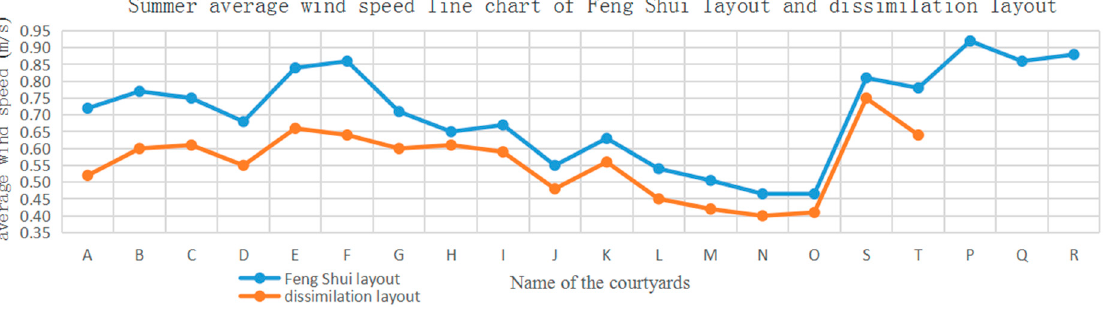
Figure 8. The average wind speed line chart for the courtyards of feng shui layout and dissimilation layout. The values of the figure was based on CFD simulation results.